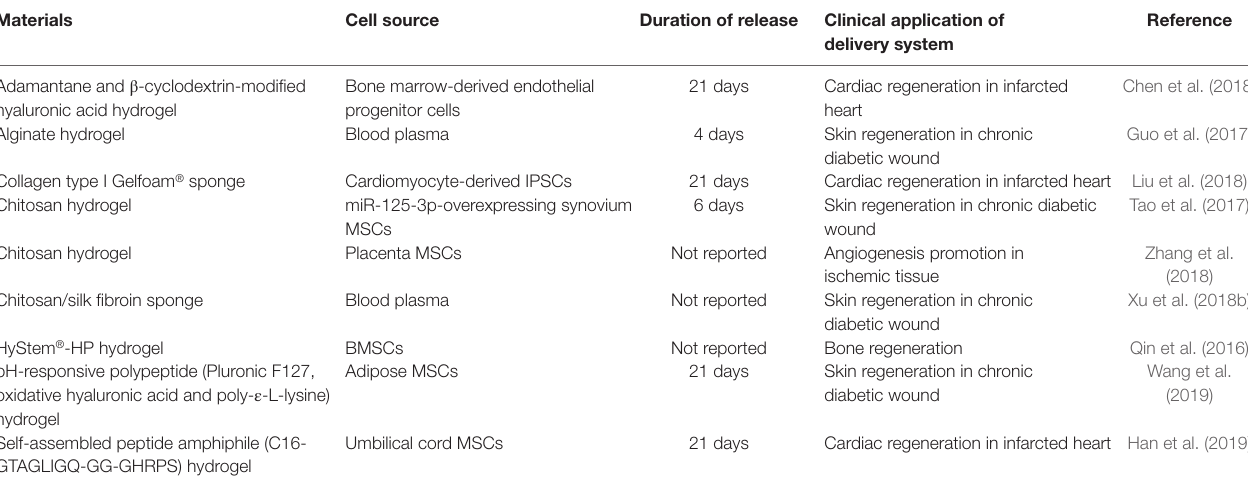
TABLE 1 | Materials used to encapsulate exosomes derived from various cell sources.